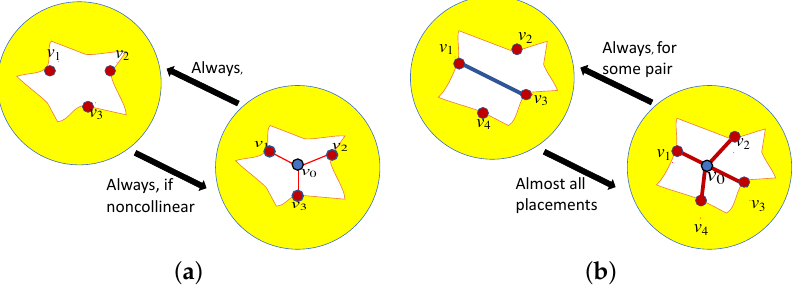
Figure 66. Inductive methods to add degree 3 ( a ) and degree 4 ( b ) vertices to C 1